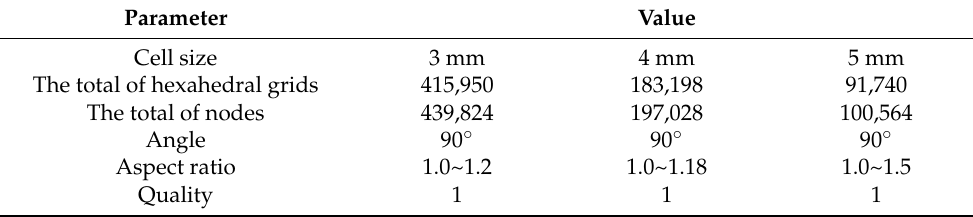
Table 1. The details of Table 1. the details of grids.